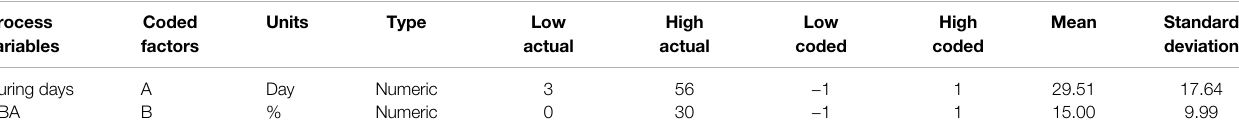
TABLE 4 | Process variables and coded